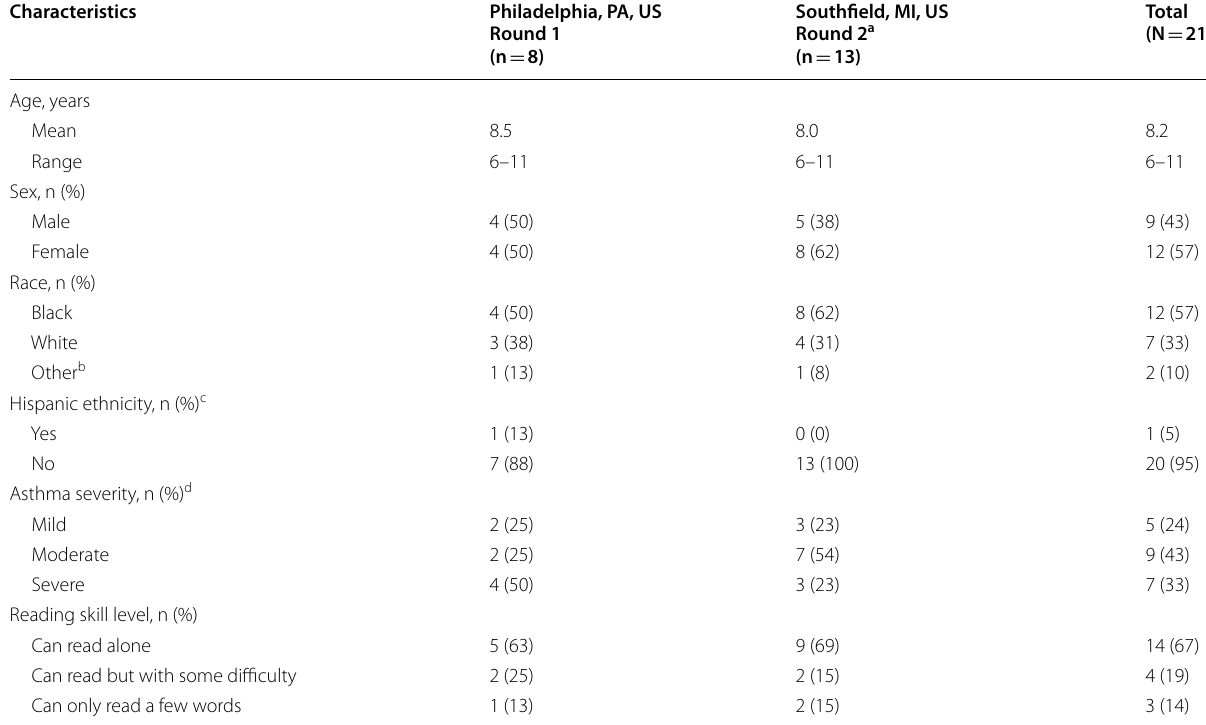
Table 5 Cognitive debriefing child participants